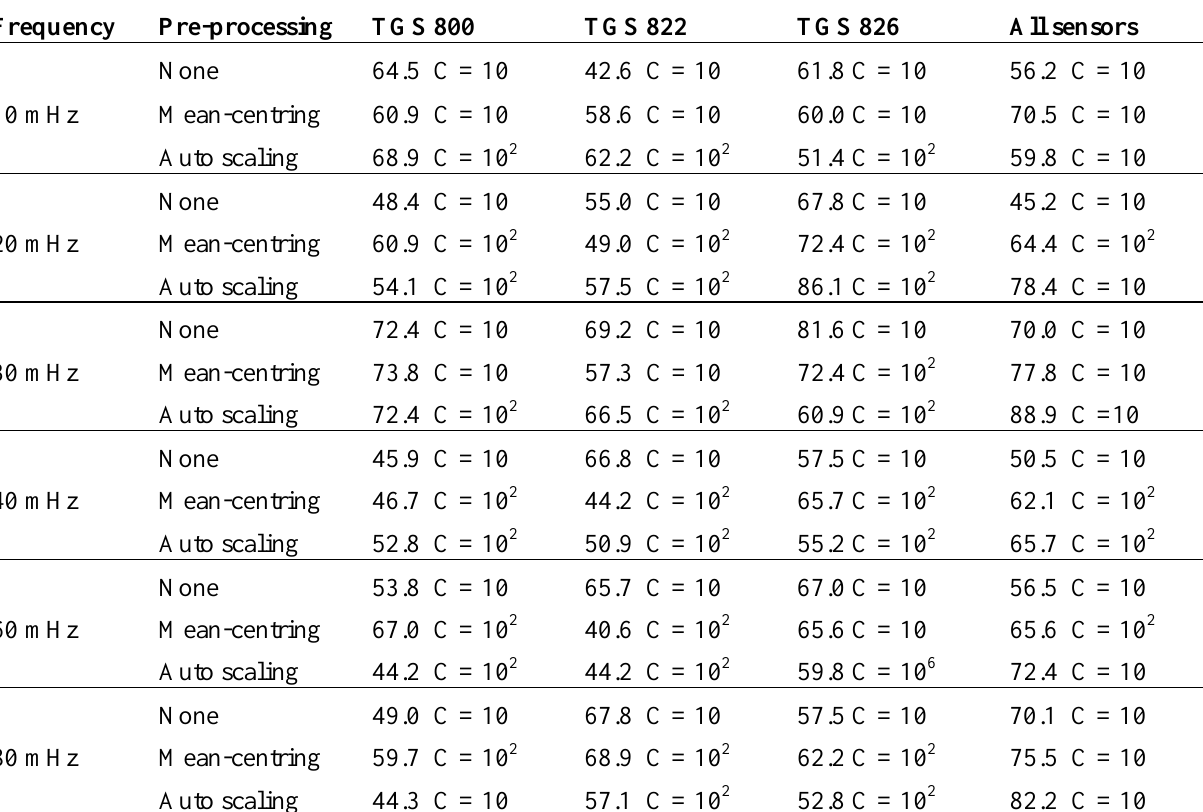
Table 4. Success rate in the simultaneous identification and quantification of vapours (%) using flow modulation. Validation results are reported. The optimal value of parameter C is also